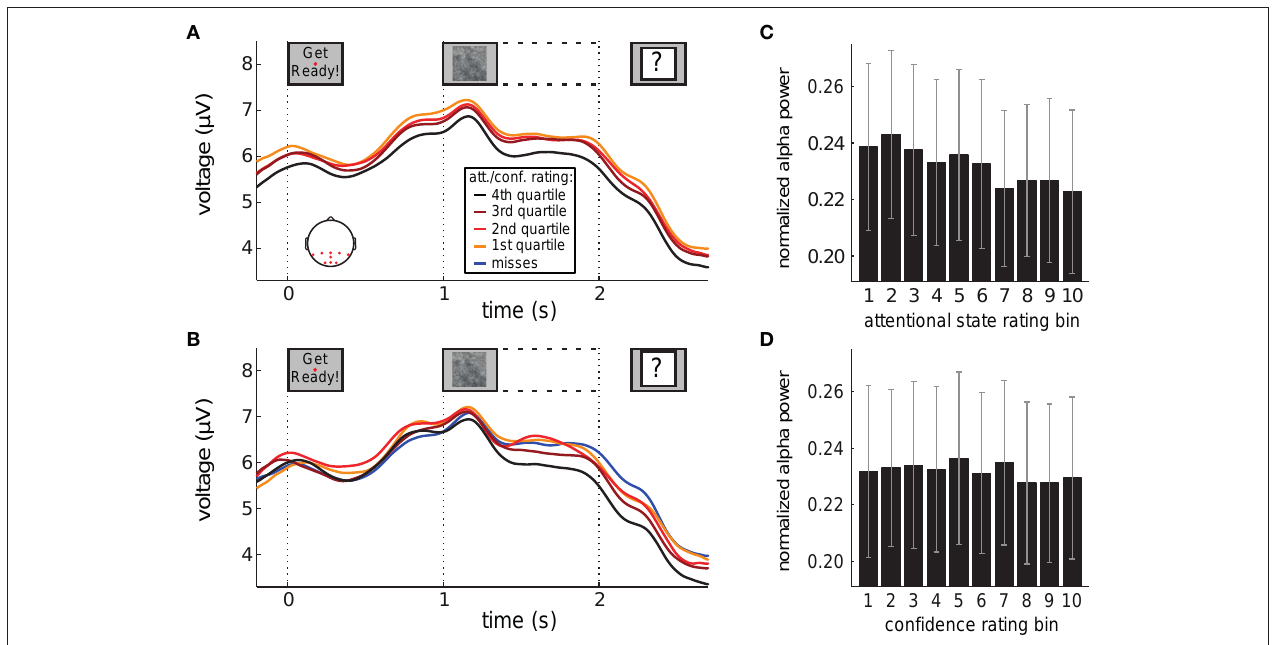
Figure 4 | Alpha power during preparation and stimulus presentation. (A,B) Grand average amplitude-modulated EEG signal after band-pass filtering at alpha frequencies, time-locked to the onset of the words “Get Ready!”, by attentional state rating quartile and confidence rating quartile, respectively. In (B) , miss trials are